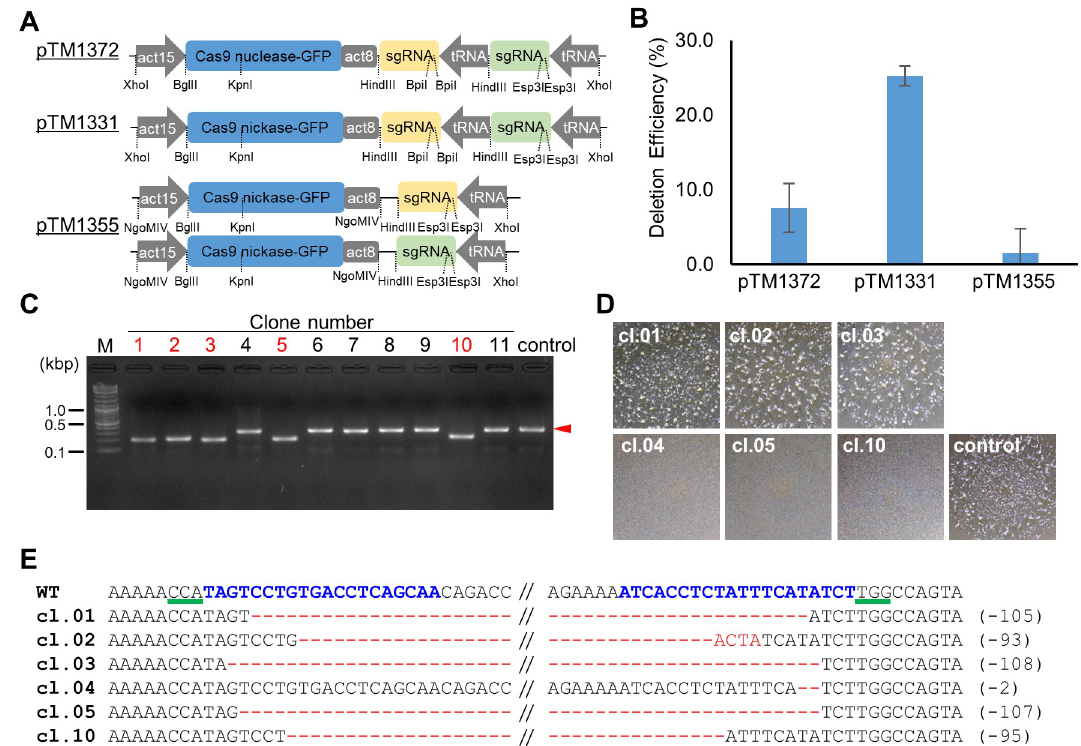
Fig 1. CRISPR/Cas9-mediated generation of deletion mutations in Dictyostelium . (A) Schematic overview of the CRISPR vectors designed to generate deletion mutations. sgRNA sequences were synthesised as pairs of oligonucleotides and integrated into the vectors using the Golden Gate assembly method. act15, act15 promoter; act8, act8 terminator; tRNA, isoleucine tRNA. (B) CRISPR- mediated deletion efficiencies. Single clones grown on SM agar plates were randomly selected and tested for deletions via PCR amplification of the target region. The error bars show the standard error of the mean based on three independent biological repeats. (C) Genomic deletions in pTM1331-expressing cells. PCR products generated using primers flanking the target sites are shown. A control reaction using AX2 cells is shown in the rightmost lane. Red arrowhead indicates PCR products found in the control. (D) Aggregation phenotypes of the mutants shown in Fig 1C. Single clones were seeded on a bacterial lawn and imaged after 4 days with a stereoscopic microscope. (E) The sequencing results of the deletion regions. The wild-type (WT) sequence of pkaC and six independent mutated sequences are shown. The sequence used as the target is shown in blue and the PAM sequences are shown by green underscores. The mutated nucleotides are in red, and the numbers in parentheses indicate the number of deleted nucleotides.